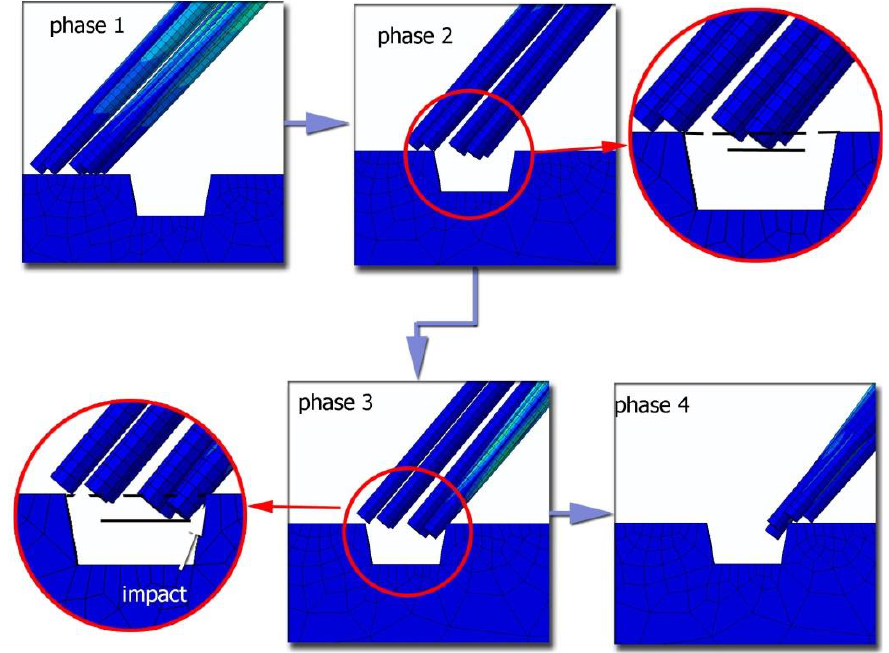
Figure 8. Simulation of the phases of fibers passing through a surface defect.